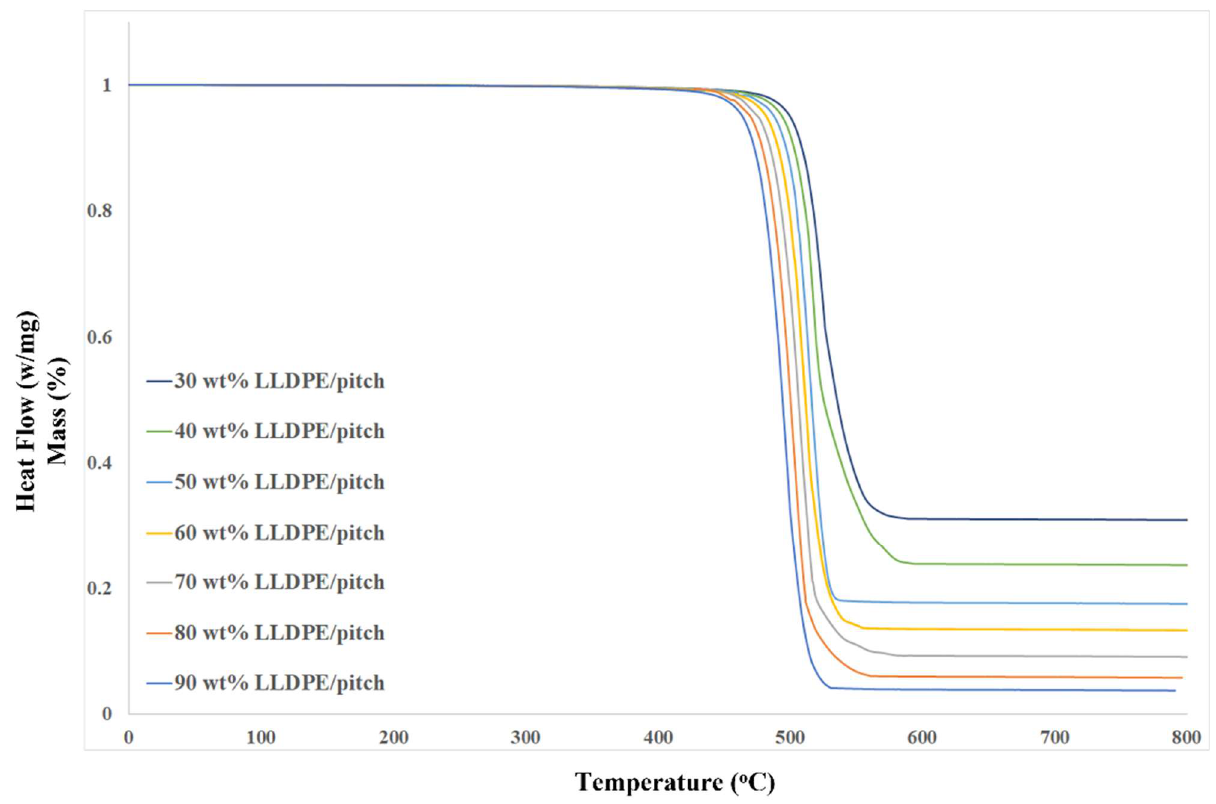
Figure 7. TGA curves for different wt% LLDPE in LLDPE/MP blends. Table 4. Thermogravimetric analysis (TGA) result for 30 to 90 wt% LLDPE/MP. Samples